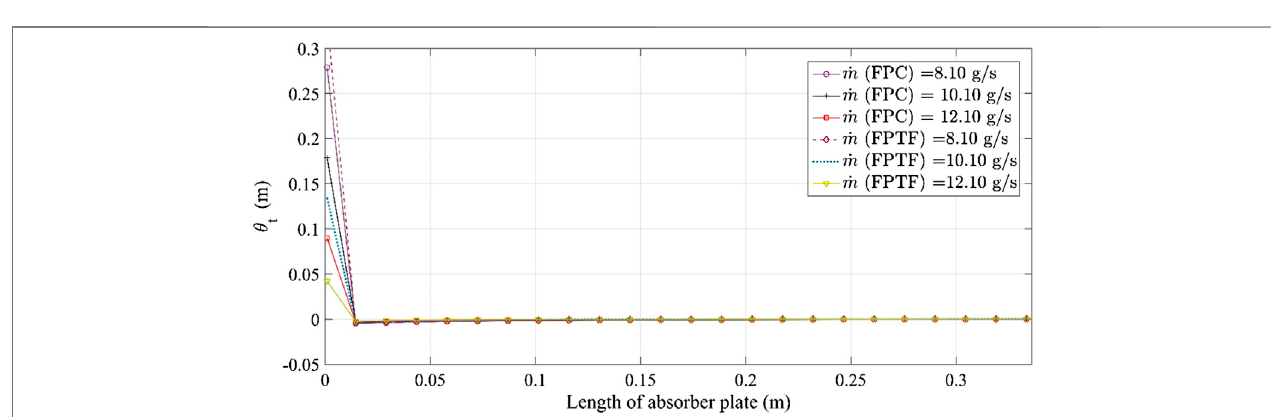
FIGURE 5 | The change in the stretching function ( f ( ζ ) with stretching factor ζ ( y